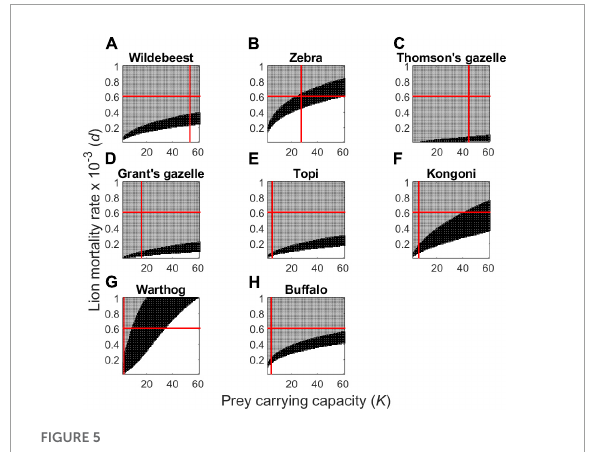
FIGURE5 Plot of dynamically unstable (unshaded), locally stable (dark shading), and unsustainable (moderate shading) outcomes for the group-dependent predator-prey model (Eqs. 3, 4), for the most common prey of Serengeti lions. The red lines depict the values of lion daily mortality rate ( d ) and prey carrying capacity ( K ) as in Figure 4 . Panels correspond to wildebeest (A) , zebra (B) , Thomson’s gazelles (C) , Grant’s gazelles (D) , topi (E) , hartebeest (F) , warthog (G) , and buffalo (H) .